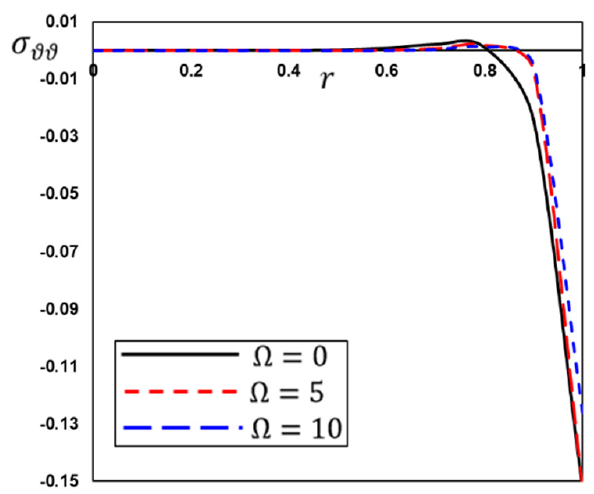
for different rotation parameter Ω . (cid:3045)(cid:3045)